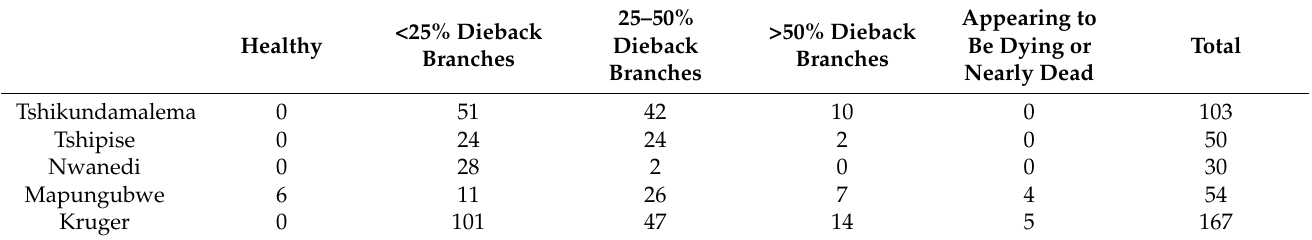
Table 3. Health status of the Anacardiaceae at the five sites sampled in this